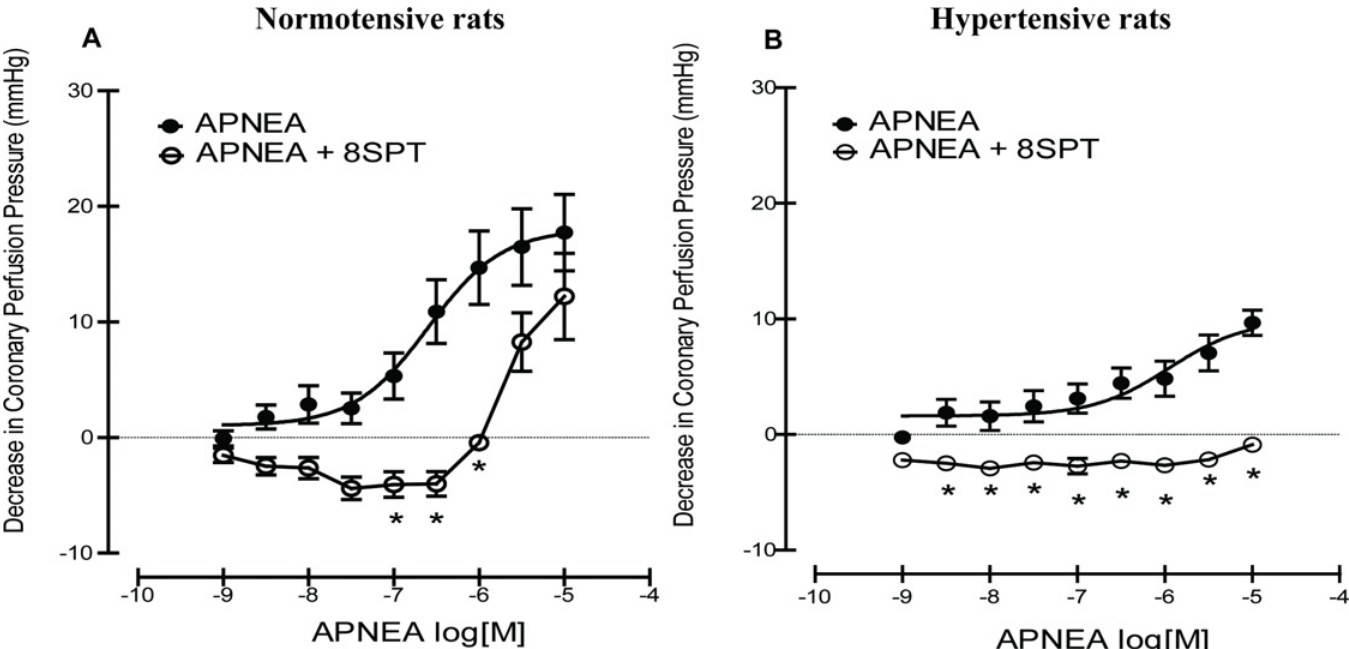
Fig 2. Concentration response curves showing the effects of the agonist APNEA in the absence and presence of 8SPT (10 -5 M) in (A) normotensive rats and (B) spontaneously hypertensive rats. Concentration response curves to APNEA were analysed using nonlinear regression, from which EC 50 values and 95% confidence intervals were also derived. One-way or two-way ANOVA were performed on the data, followed by Tukey ’ s Multiple Comparison Test/Bonferroni for individual comparisons when significant effects were detected. * denotes statistical significant difference (p < 0.05) to absence of antagonist